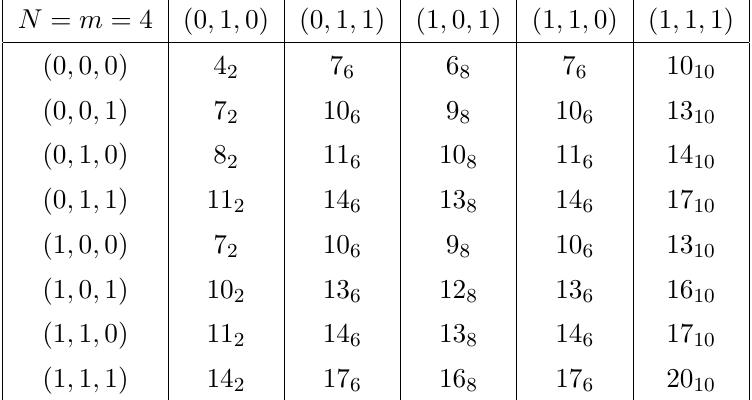
Table 1 . Energies of the su(4) model (2.1) with N = 4 spins and their corresponding degeneracies (indicated by